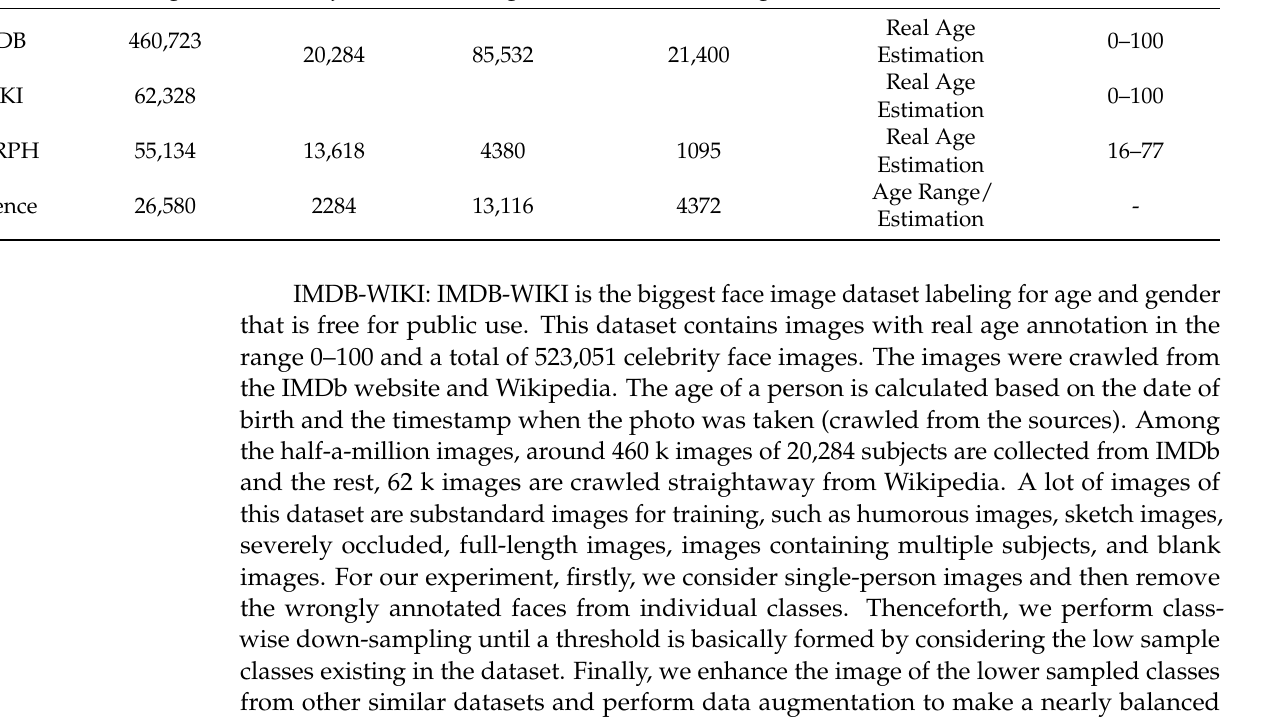
Figure 8. Exemplar images from the Adience dataset used for the gender estimation experiment. Table 4. The particulars of the datasets used for our experiments with the corresponding training and testing split.